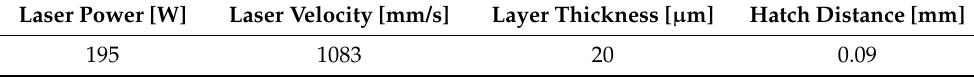
Table 2. EOS 316L manufacturing parameters.